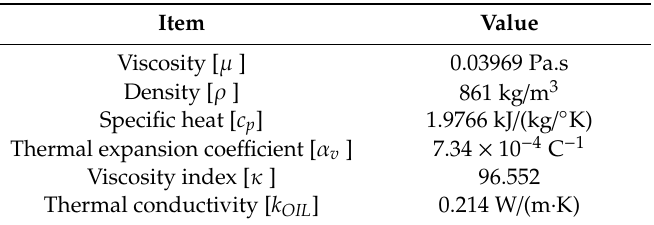
Table 1. Properties of ISO VG46 (at 40 ◦